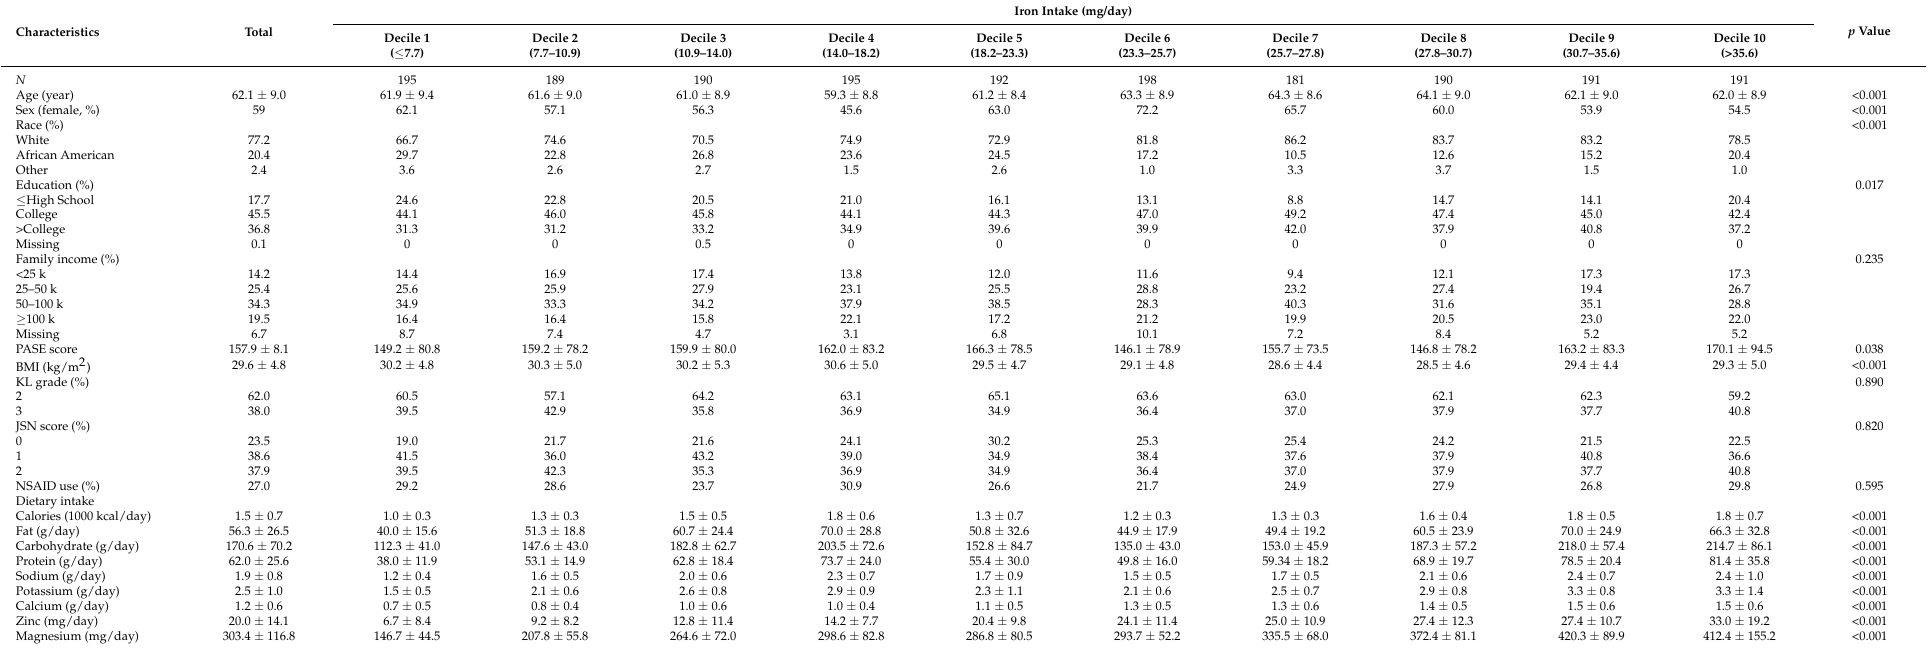
Table 1. Population characteristics by categories of dietary iron